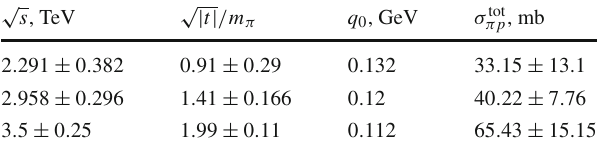
Fig. 6 Extractedtotal π + p cross-sections presentedinthe Table 1ver- sus different parametrizations: [34] (solid), [35] (dashed), [36] (dotted) and [37, 38] (dash-dotted). The interval of t related to the η region of the LHCf is η > 10 . 76 Table 1 Values of the π p total cross-sections extracted from the LHCf data [19] and also depicted in the Fig. 6. Corresponding average | t | values and q 0 ( q t < q 0 ) are also shown. Backgrounds from ρ and a 2 exchanges are taken into